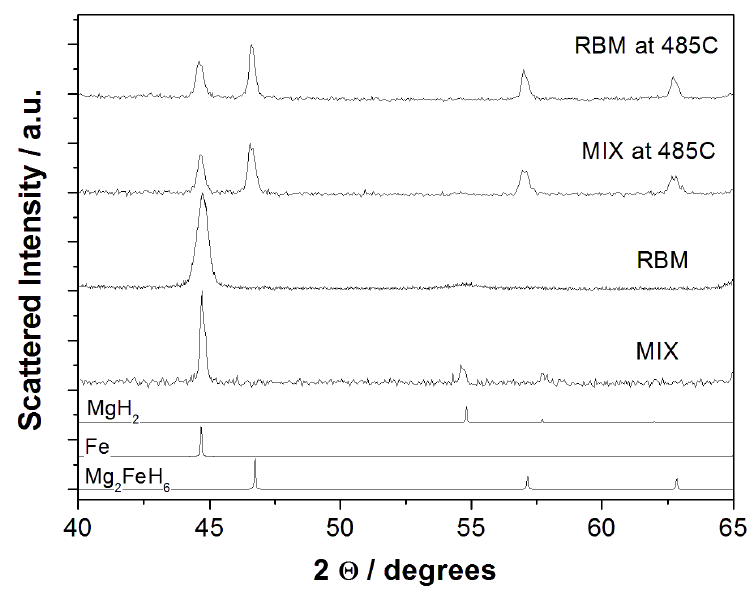
Figure 2. XRD patterns of the RBM and MIX samples before hydrogen sorption and after H 2 sorption at 485 °C.